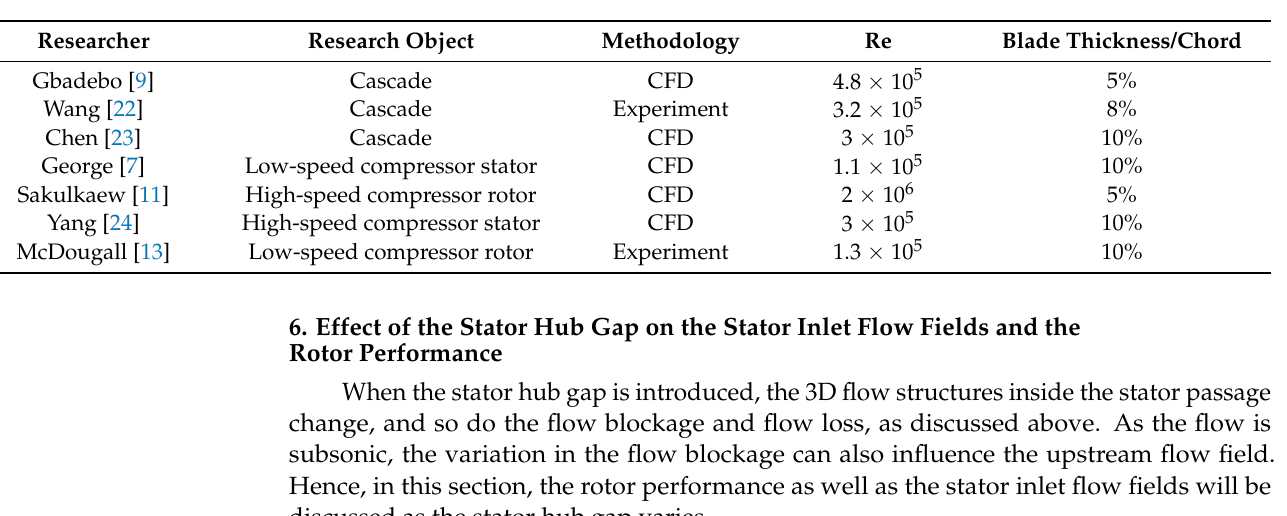
Figure 17. Published results about the optimum gap. ( a ) Variation in loss; ( b ) variation in efficiency; ( c ) variation in pressure rise. Table 1. Detail parameters of the quoted studies.